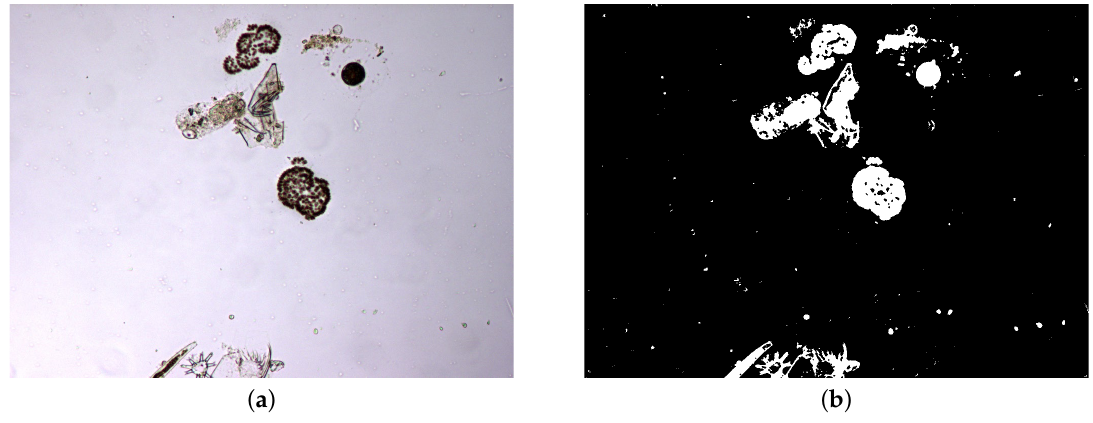
Figure 2. Example of foreground-background separation. ( a ) Original image. ( b ) Binary map separating the foreground from the